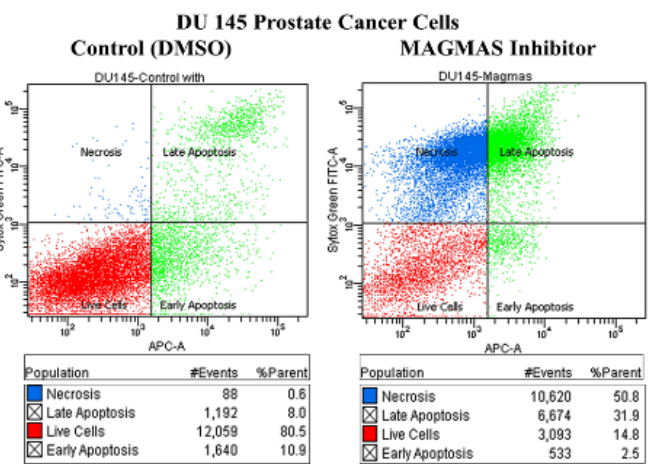
Figure 4. The mode of cell death treated by BT#9. ( A ) MTS viability assay showed that general caspase inhibitor (Z-VAD) did not protect BT#9-induced cell death in PC-3 cells (#: p > 0.05). ( B ) Dot plot of fluorescence shift in PC-3 cells after being treated with 20 µ M BT#9 for 4 h. The ratios of red/green (Q2/Q3) were decreased from 81.5/17.3 (untreated) to 26.7/71.8 (treated), indicating the loss of MMP. ( C ) PC-3 cells were treated by 1 µ M or 10 µ M BT#9 for 24 h; Western blot showed decreased total caspase − 3, indicating the activation of caspase-3. ( D ) Fluorescence microscopy also confirmed that smaller percentage of cleaved caspase-3 and cleaved PARP in PC-3 cells treated by 10 μ M BT#9 when compared with positive control. ( E ) TUNEL based Apo-BrdU apoptosis rate and MTS cell viability assay treated by BT#9. ( F ) PI staining by fluorescence microscopy; dramatic cell death treated by BT#9 at the concentration of 10 or 20 μΜ were detected. ( G ) Annexin V/SYTOX Green Assay for DU-145 cells treated by BT#9(10 μ M). Each experiment was repeated three times. # p > 0.05 (Unpaired two-tailed t test).